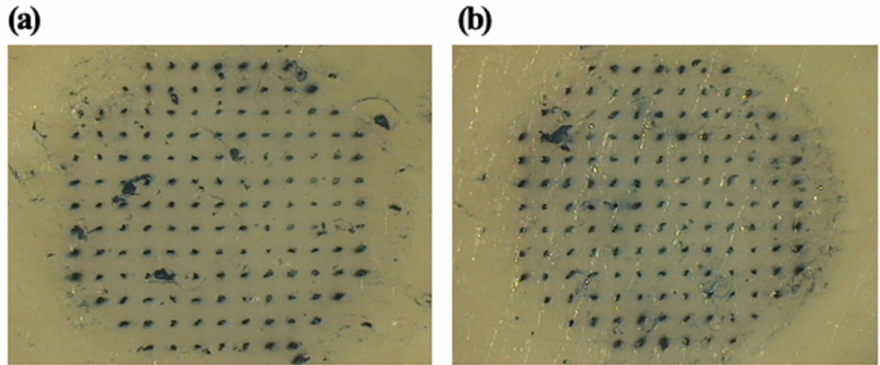
Figure 4. Optical micrograph of porcine skin pierced by an array of ( a ) uncoated MNs and ( b ) coated MNs subsequently exposed to Trypan Blue dye.